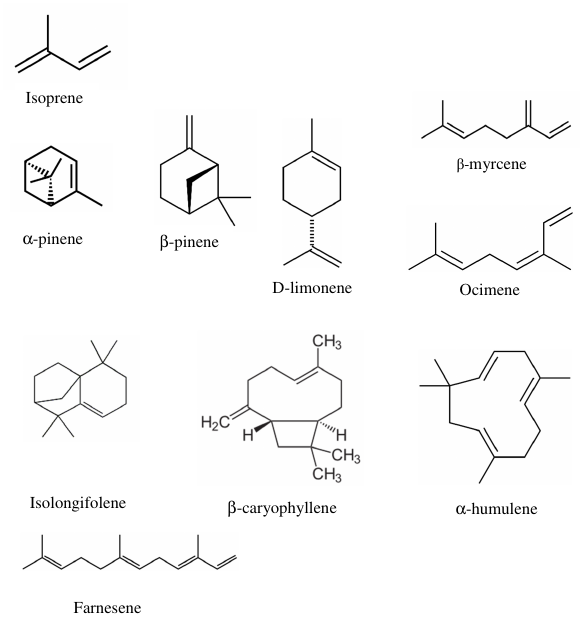
Figure 1. Molecular structures for the terpenes characterized in this